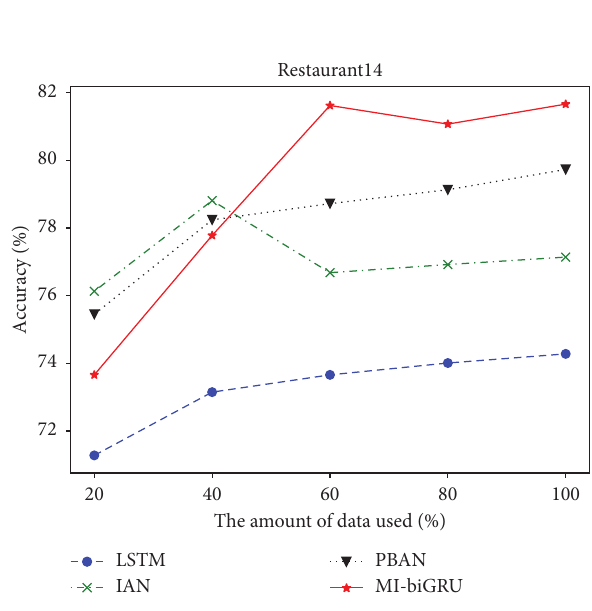
Figure 3: Accuracy trend of baseline models in restaurant